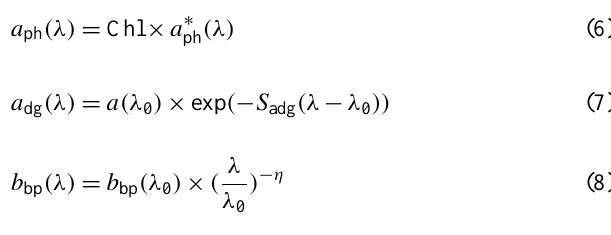
-0.8 log max(R (443),R (488))/R (547) rs rs rs Fig. 12. Algorithm tuning for the OC3M band-ratio algorithm. All Fig. 12. Algorithm tuning for the OC3M band-ratio algorithm. All data were 703 data were collected from in situ measurements. The green crosses collected from in situ measurements. The green crosses and green curve are for 704 and green curve are for the OC3M algorithm with default param- the OC3M algorithm with default parameterization, while the blue dots 705 eterization, while the blue dots represent local data collected from represent local data collected from NSCS coastal waters. The blue curve is the 706 NSCS coastal waters. The blue curve is the locally tuned algorithm, with parameterization annotated on the figure. locally tuned algorithm, with parameterization annotated on the figure. 707